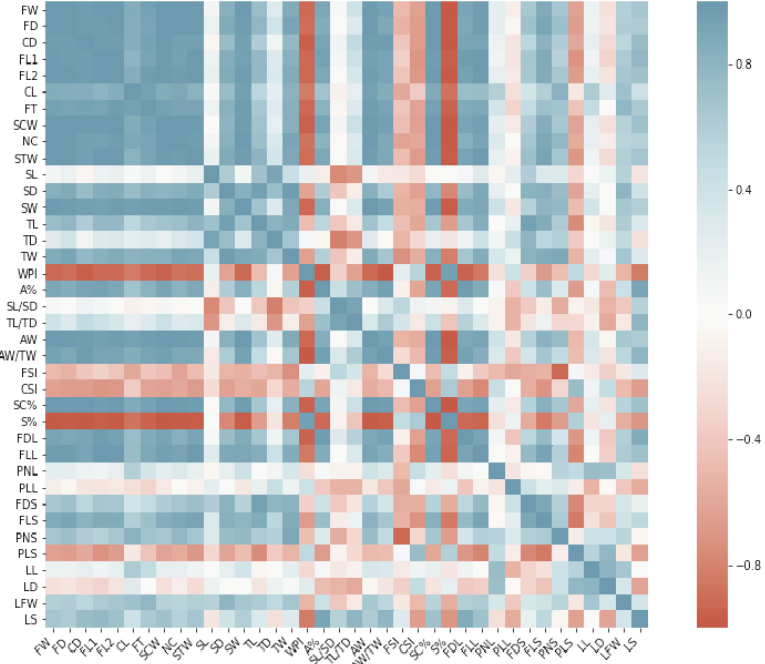
Fig. 1 ­ Pearson's correlation matrix of the quantitative traits in pomegranate accessions, visualized as a heat map plot. For explanation of character symbols, see table